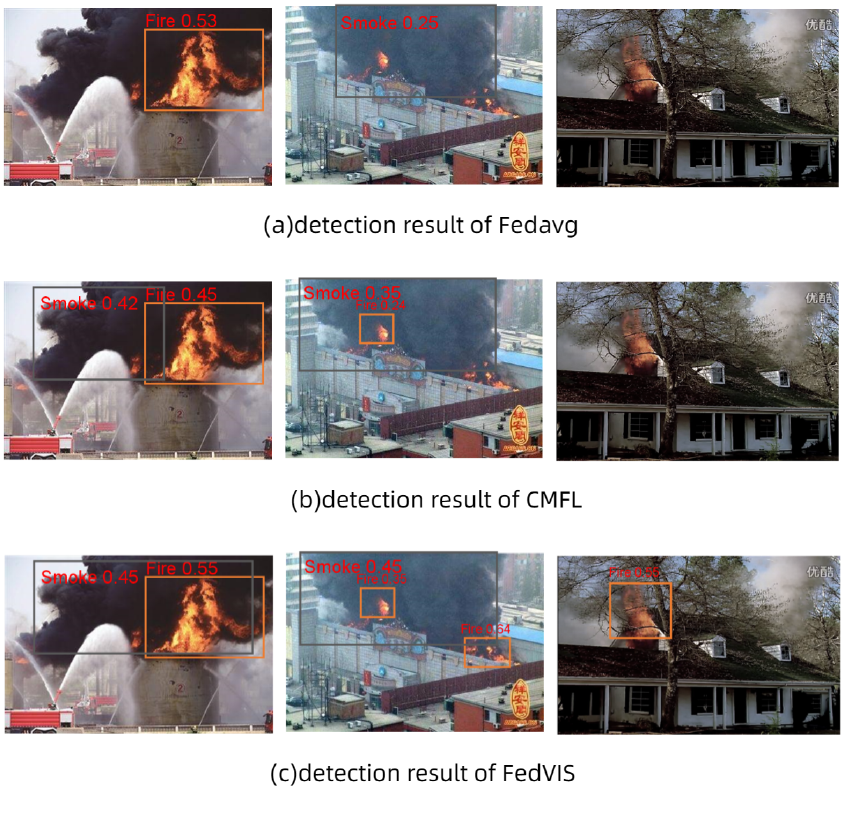
Figure 8. Comparison of the actual detection effect of FedAvg, CMFL, and FedVIS. The figure ( a ) shows the detection result of FedAvg. The figure ( b ) shows the detection result of CMFL. The figure ( c ) shows the detection result of FedVIS. For the detection of visible flames and smoke, FedVIS performs best. For the detection of visible smoke and inconspicuous flames, FedVIS performs